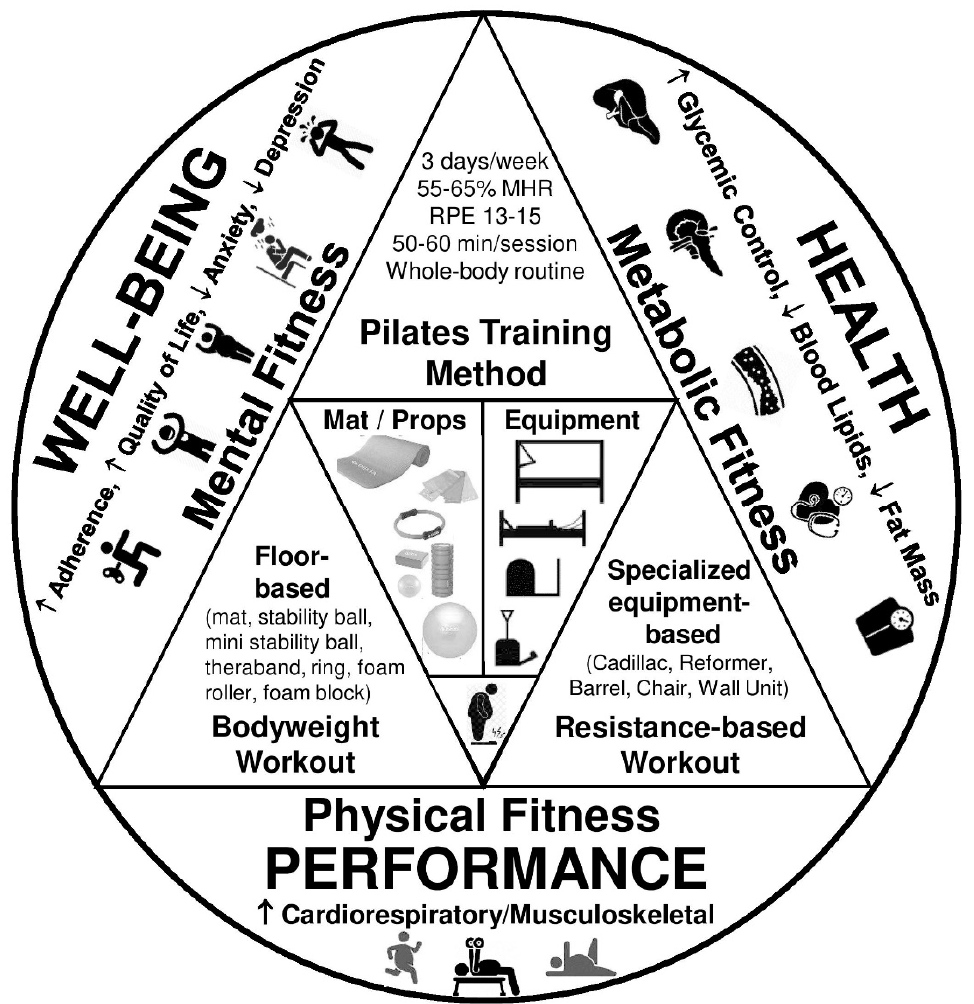
Figure 1. The psychophysiological effects of Pilates training. MHR: maximum heart rate; RPE: rating of perceived exertion. [32–36,38,39,52].